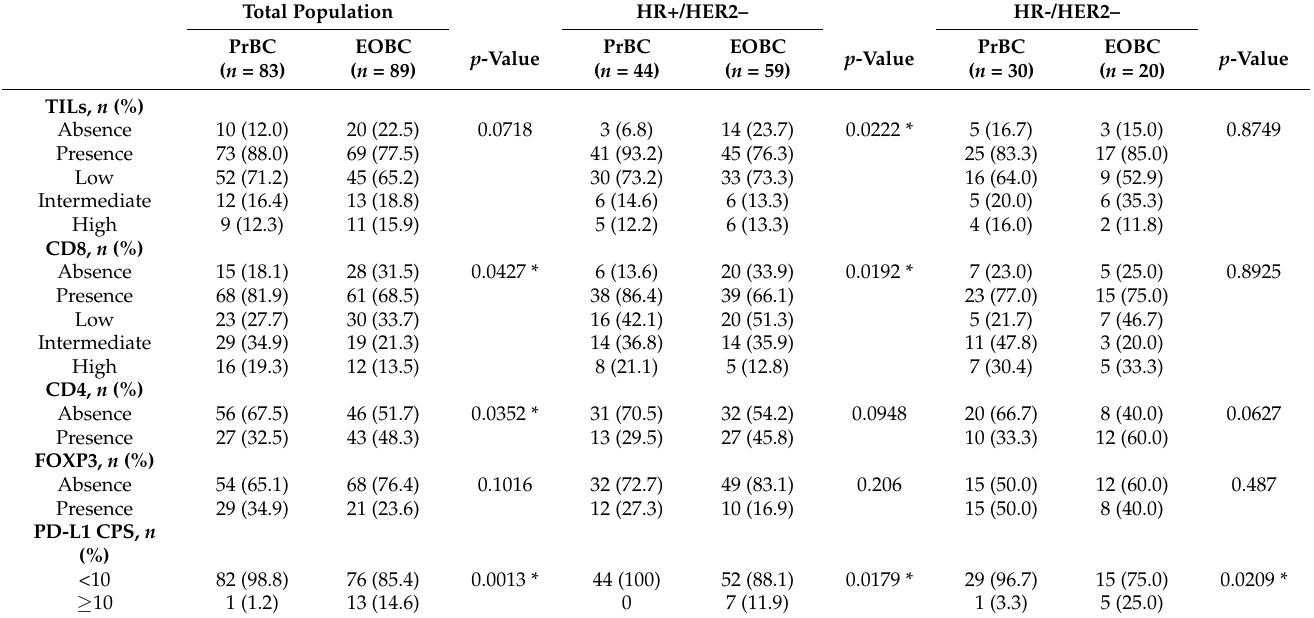
Figure 2. Analysis of biomarker status in the study population and controls. ( A ) Estrogen receptor (ER) and progesterone receptor (PgR) expression. ( B ) Prevalence of the three molecular clusters in the analyzed cases. HR, hormone receptors; TN, triple-negative breast cancer. Significant correlations among the different subset of patients (color-coded based on the legend on the right) are highlighted with a star (*). Table 2. Relative prevalence of TILs subpopulation in the tumor stroma and PD-L1 expression in breast cancer subtypes. PrBC, breast cancer during pregnancy; EOBC, early-onset breast cancers; HR, hormone receptors; TILs, tumor-infiltrating lymphocytes; FOXP3, forkhead box P3; PD-L1, programmed death-ligand 1; CPS, combined positive score. Significant correlations are highlighted with a star